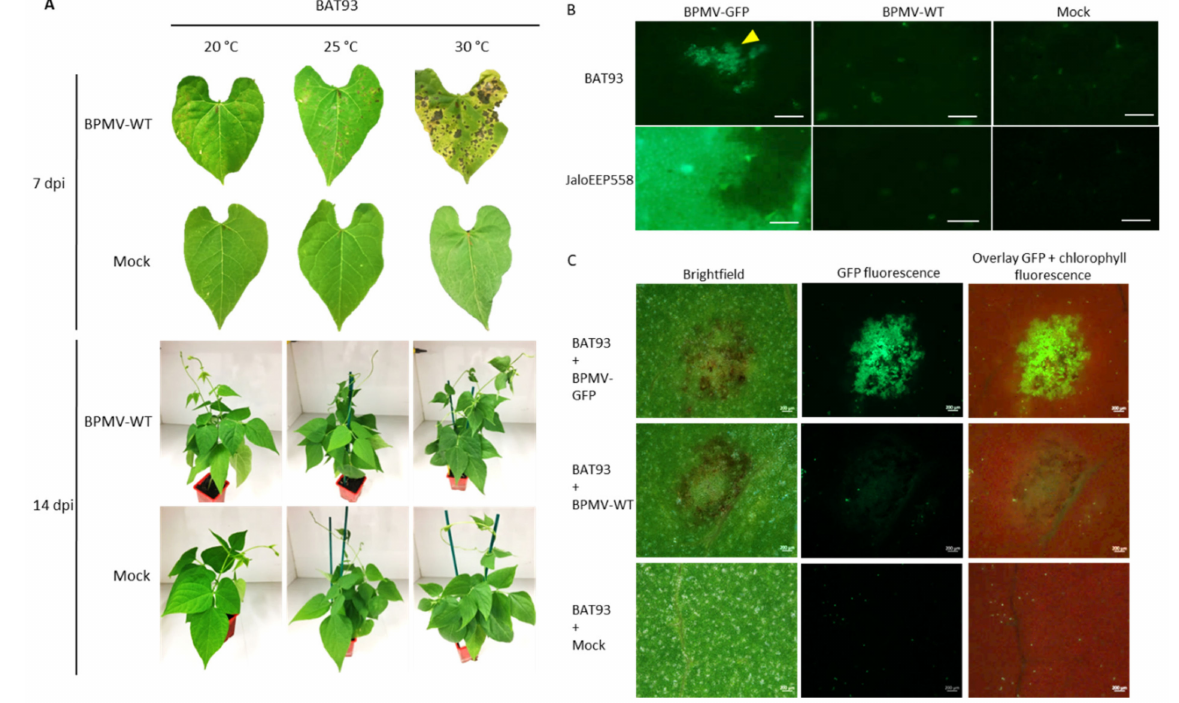
Figure 2. Elevated temperatures promote BPMV multiplication and cell-to-cell movement in the inoculated leaves of cv. BAT93 and larger local Hypersensitive-Response lesions are induced: ( A ) Representative pictures of local HR lesions on six BAT93-inoculated leaves from six different plants at 20 ◦ C, 25 ◦ C and 30 ◦ C, at 7 days post-inoculation (dpi) with BPMV-WT (upper panel) and six whole plants of BAT93 at 20 ◦ C, 25 ◦ C and 30 ◦ C, 14 dpi with BPMV-WT (lower panel). Mock was used as control. This experiment was performed at least 3 times with similar results. ( B ) Microscopic observations of BPMV-GFP accumulation in inoculated leaves of BAT93 and JaloEEP558 grown at 25 ◦ C. The BPMV-GFP construct expressing GFP as an individual protein processed from the RNA2 polyprotein was used as a reporter of BPMV accumulation. BPMV-WT and Mock were used as control. All infection assays were made at 25 ◦ C. Observations of GFP fluorescence (indicated by a yellow triangle) were made at 4 dpi and are representative of six BAT93-inoculated leaves sampled on six different plants. Scale bars = 250 µ m. ( C ) Microscopic observations of BPMV-GFP accumulation in inoculated leaves of BAT93 grown at 30 ◦ C. The BPMV-GFP construct expressing GFP as an individual protein processed from the RNA2 polyprotein was used as a reporter of BPMV accumulation. From left to right: brightfield, BPMV-GFP accumulation (green), overlay of chlorophyll fluorescence (red) and BPMV-GFP accumulation (green). BPMV-WT and Mock were used as control. All infection assays were made at 30 ◦ C. Observations of GFP fluorescence were made at 4 dpi and are representative of six BAT93-inoculated leaves sampled on six different plants. Scale bars = 200 µ